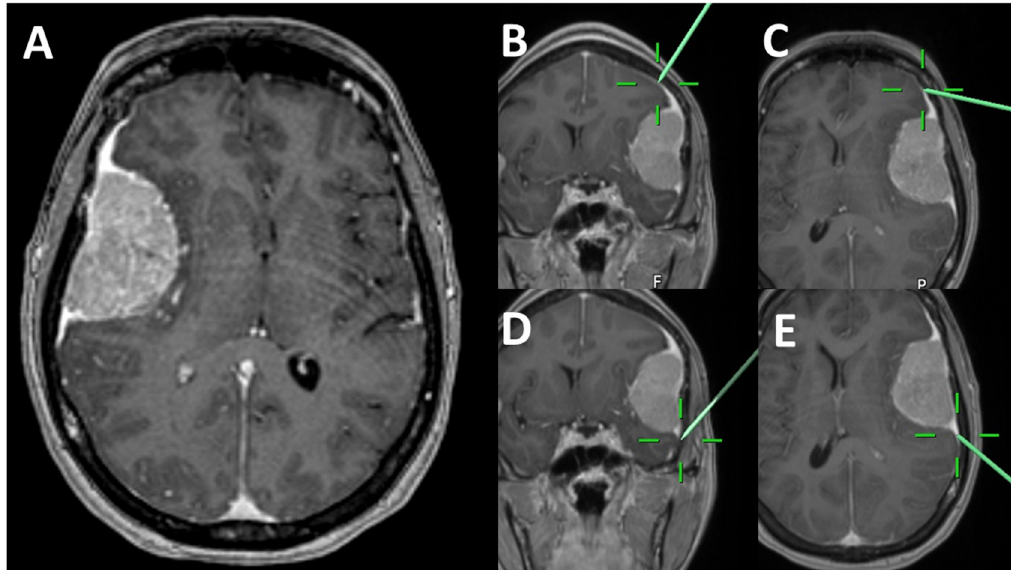
Figure 2. Illustrative image demonstrating intraoperative screenshots demonstrating the localization of dural tail specimens. ( A )—preoperative MRI demonstrating a convexity meningioma with a dural tail. ( B – E )—intraoperative screenshots of the locations of dural tail specimens. MRI, magnetic resonance imaging.